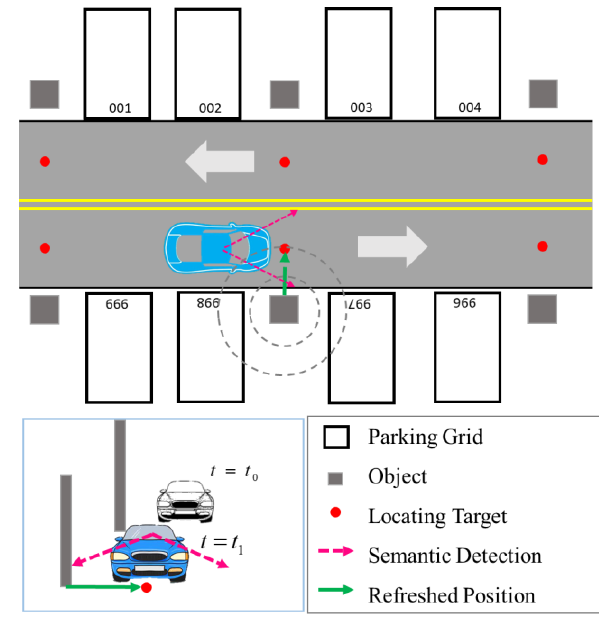
Figure 6. Schematic of proposed ODR